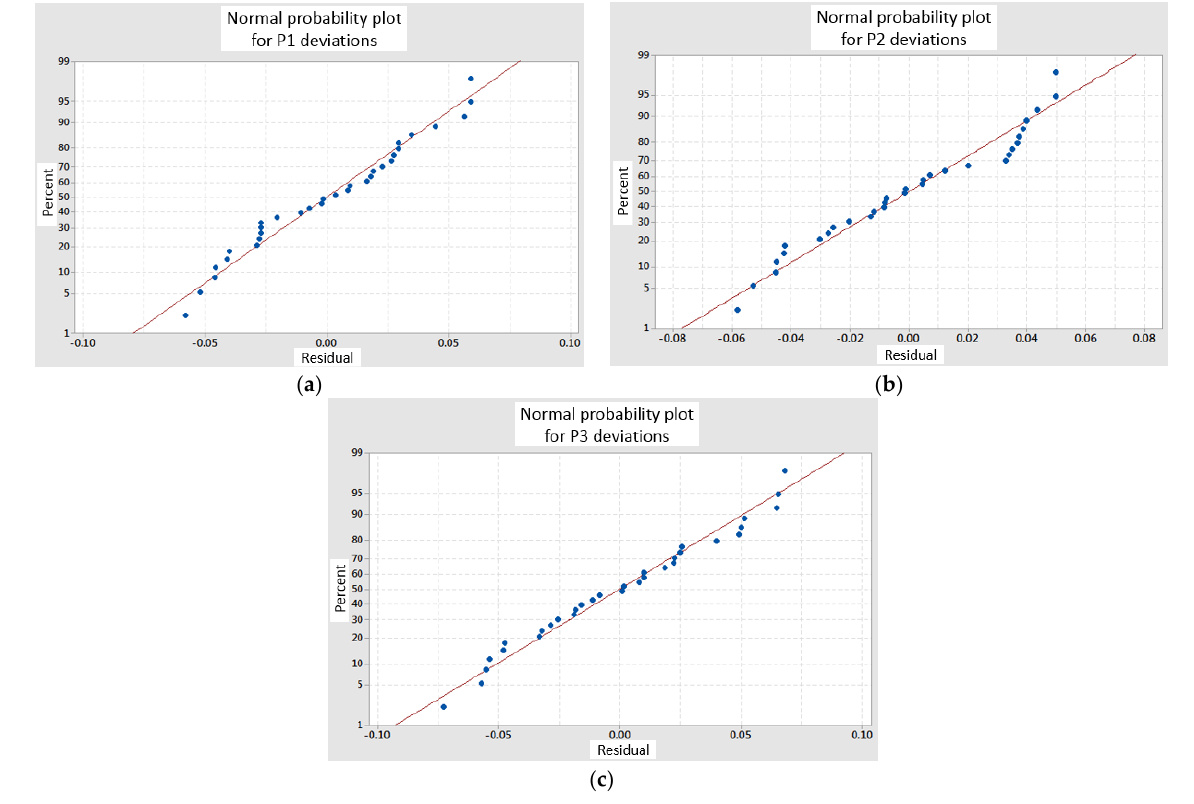
Figure 17. Normal probability plots, reprinted with permission from ref. [5]: ( a ) deviations P1; ( b ) deviations P2; ( c ) deviations P3.